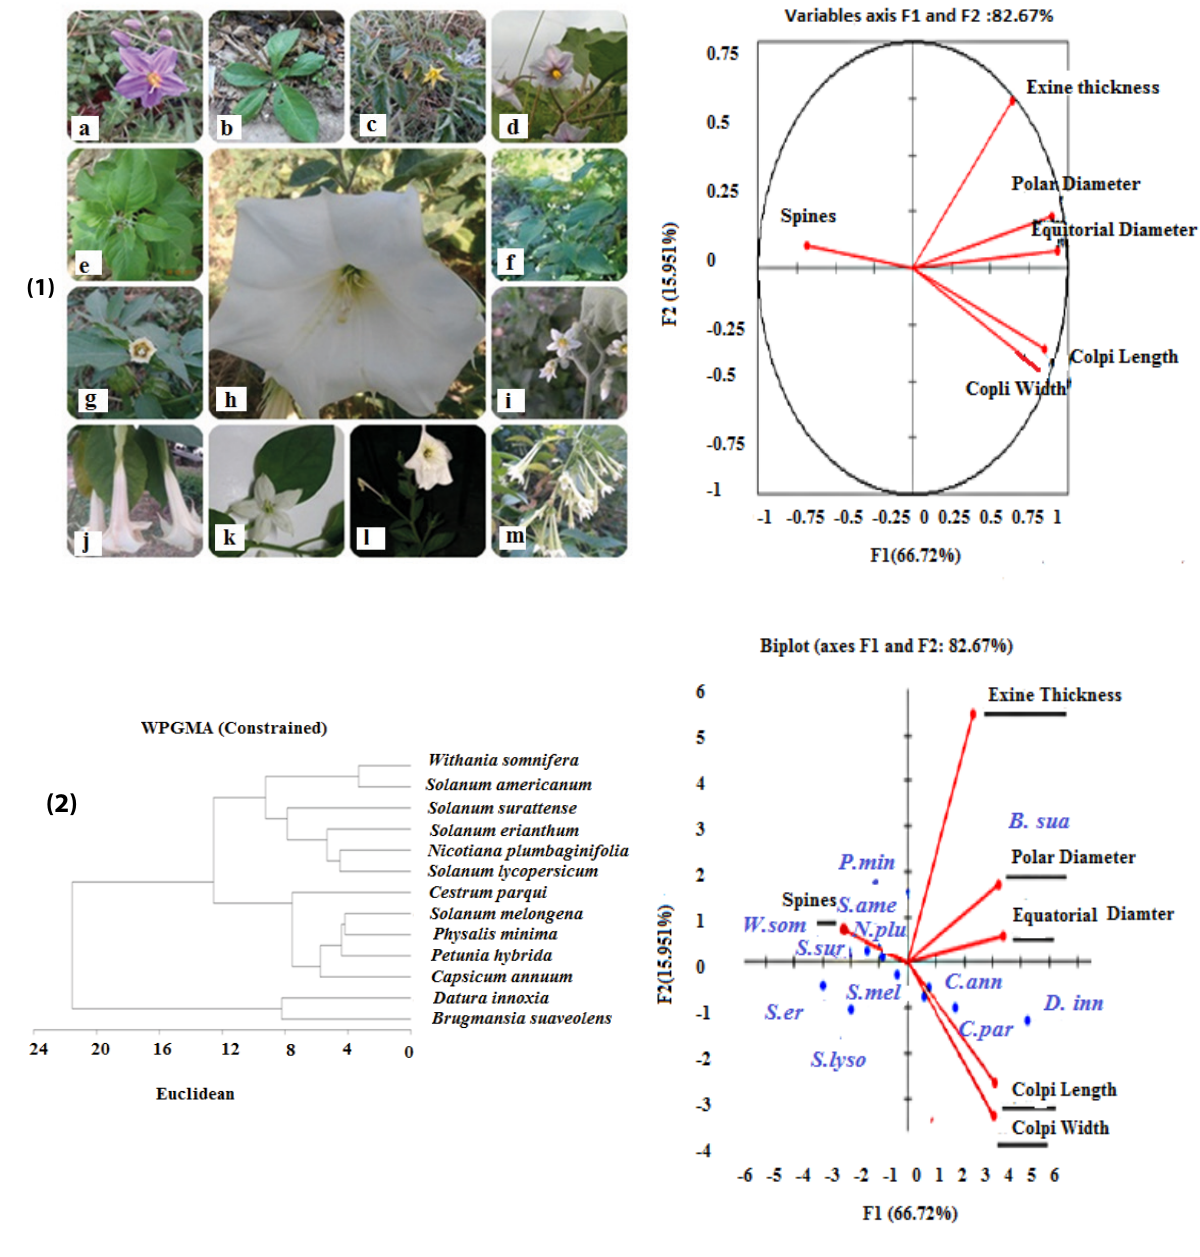
Figure 1. (1) Studied taxa of family Solanaceae (A) Solanum surattense (B) Nicotiana plumbaginigolia (C) Solanum lycopersicum(D) Solanum melongena (E) Withania somnifera (F) Solanum americanum (G) Physalis minima (H) Datura innoxia (I) Solanum erianthum (J) Brugmansia suaveolens (K) Capsicum annuum (L) Petunia hybrida (M) Cestrum parqui (2) Cluster analyses showing the relationship among the studied Solanaceous species based on the palynological characters. (3) Principal Component Analysis (PCA) among the studied Solanaceous species based on palynological characters. B.sua: Brugmansia suaveolens, C.ann: Capsicum annuum, C.par: Cestrum parqui, D.inn: Datura innoxia, L.esc: Solanum lycopersicum, N.plu: Nicotiana plumbaginifolia, P.alb: Petunia hybrida, P.min: Physalis minima, S.ame: Solanum americanum, S.eri: Solanum erianthum, S.mel: Solanum melongena, S.sur: Solanum surattense , W.som: Withania